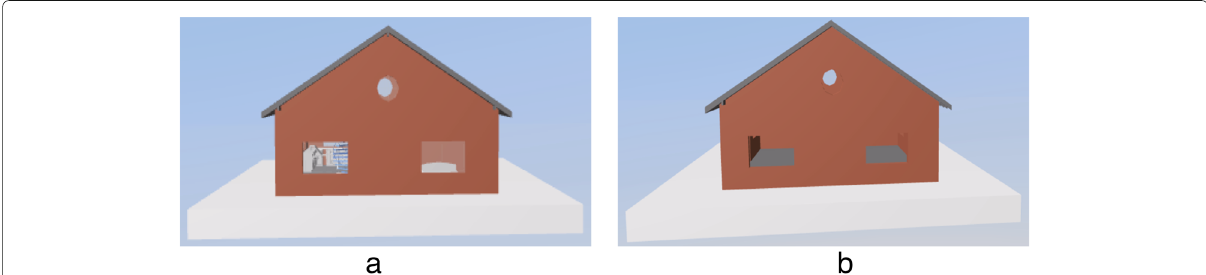
Fig. 2 External component extraction based on the bounding box. The external windows and doors are extracted incorrectly. a Original model b Result based on the bounding box algorithm